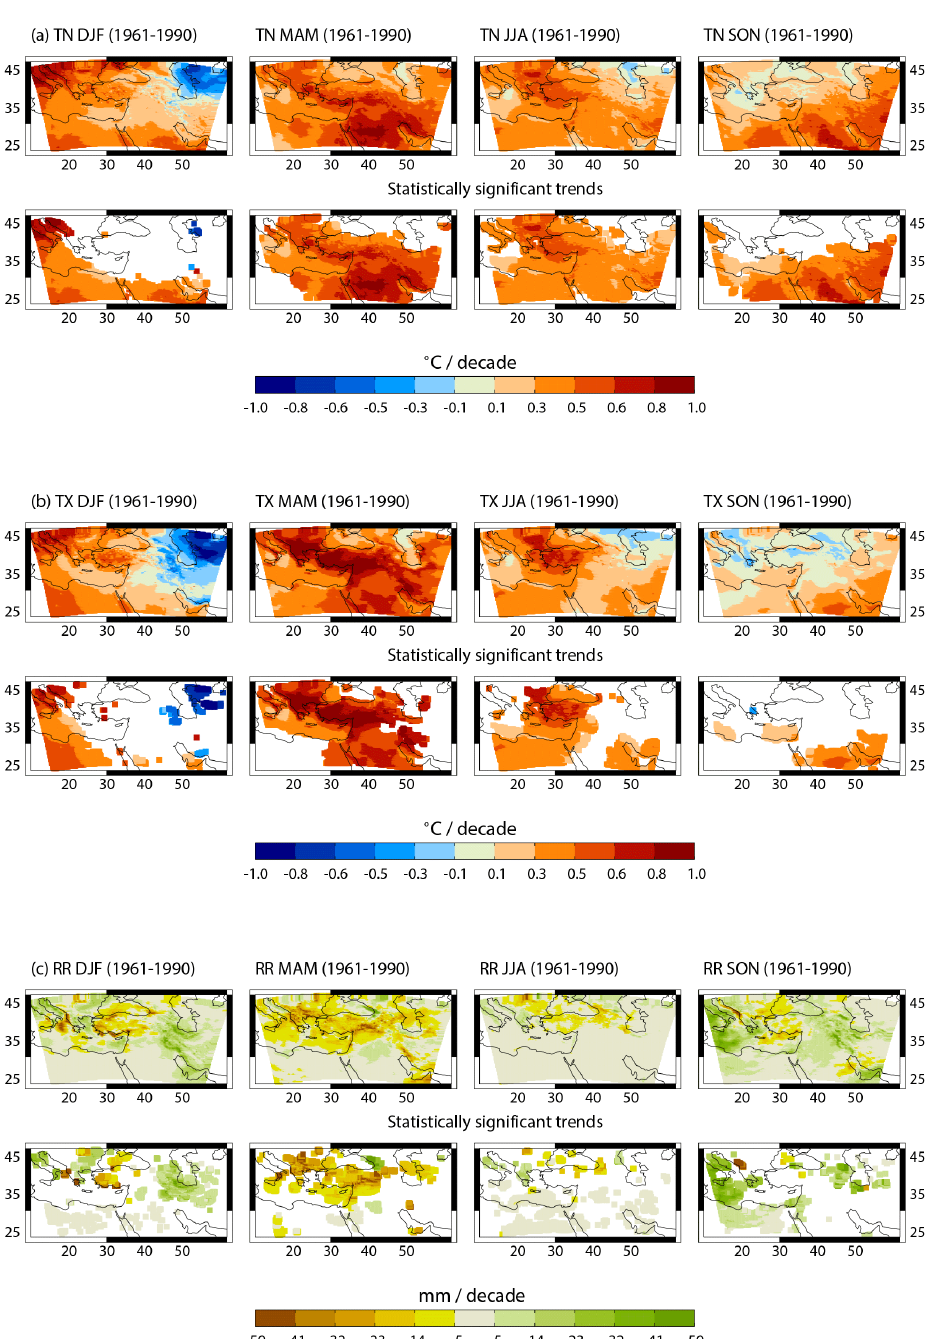
Figure 4. Trends in seasonal (winter: DJF, spring: MAM, summer: JJA, autumn: SON) minimum (TN), maximum (TX) temperatures and precipitation (RR). Upper panels in every set of (a) , (b) , (c) present all trends, while lower panels show only grid points with statistically significant trends over the period